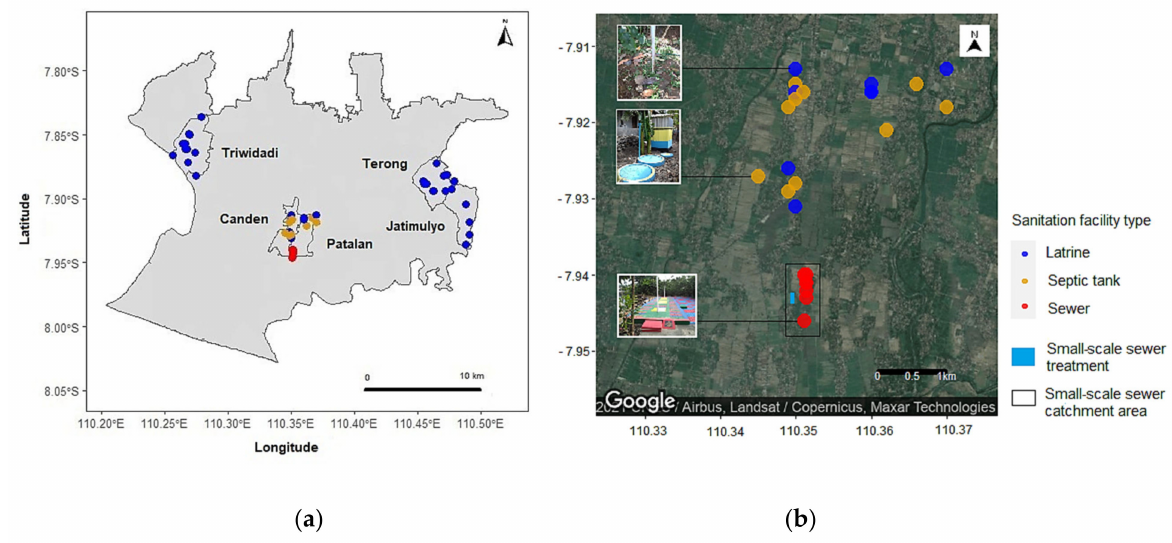
Figure 3. ( a ) Sampling locations, ( b ) location of the small-scale sewer system and its catchment area in Canden. The dots represent the households collected water samples. Table 1. Topography, groundwater source, number of well types, and sanitation facilities in sampling locations of each